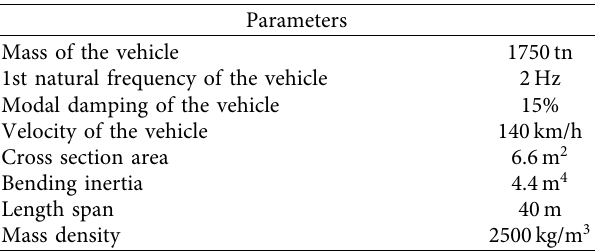
Table 2: Parameters of the instrumented vehicle and the con- sidered bridge